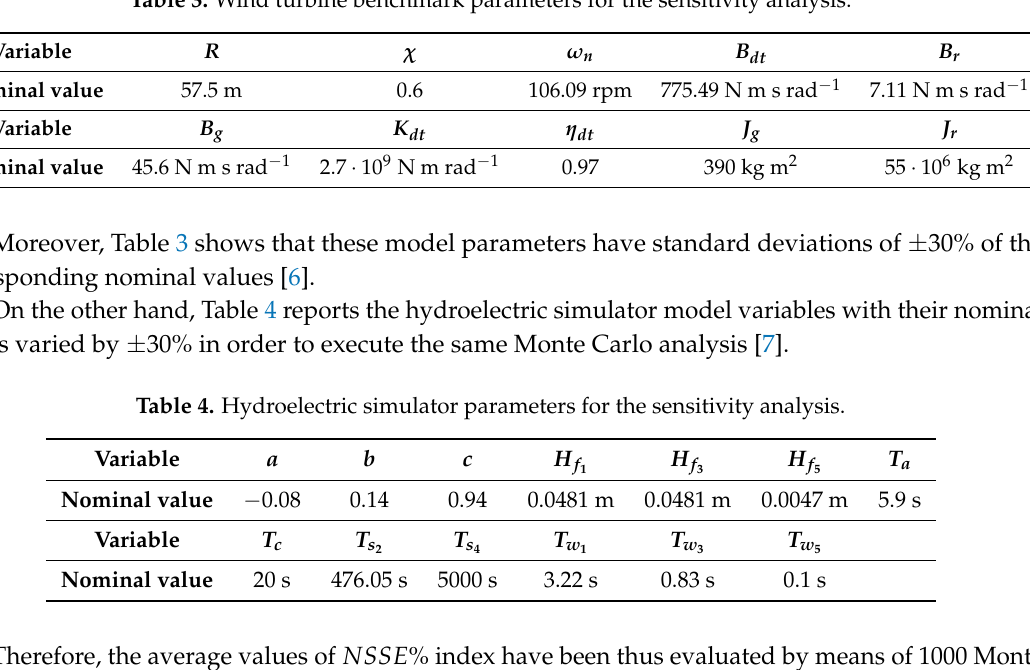
Table 3. Wind turbine benchmark parameters for the sensitivity analysis.